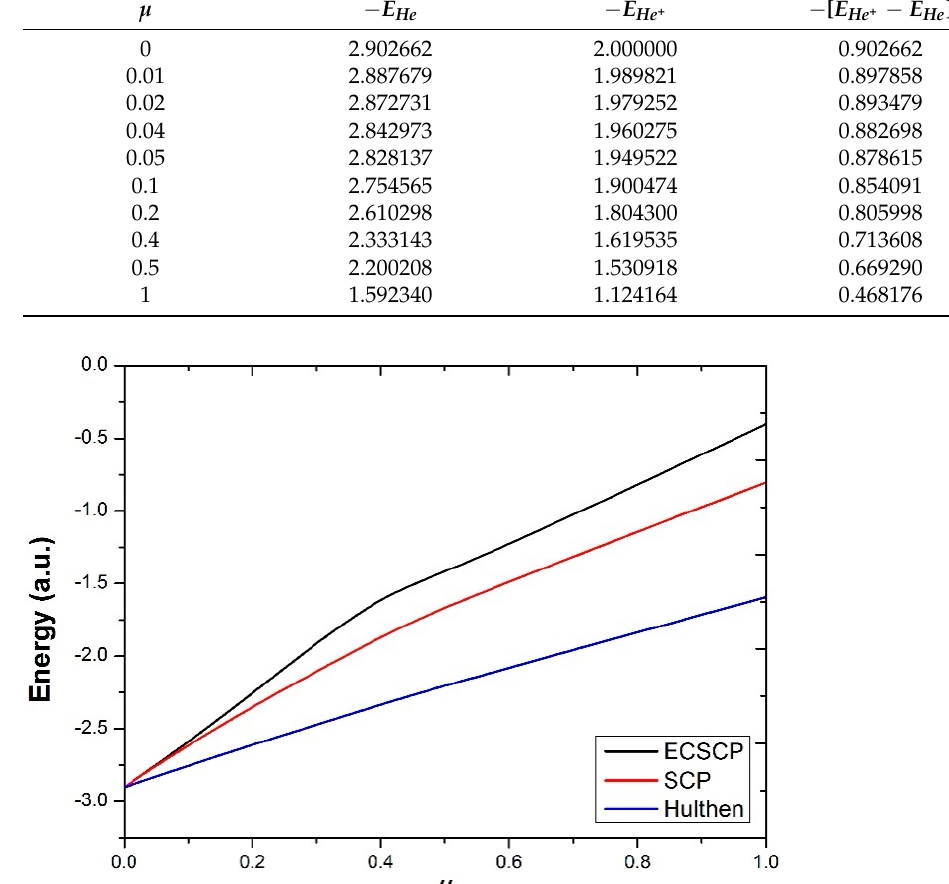
Figure 1. Groundstate energy of the helium atom in SCP, ECSCP, and Hulth é n potentials for different Figure 1. Ground state energy of the helium atom in SCP, ECSCP, and Hulthén potentials for differ- values of the screening parameter µ μ ent values of the screening parameter .